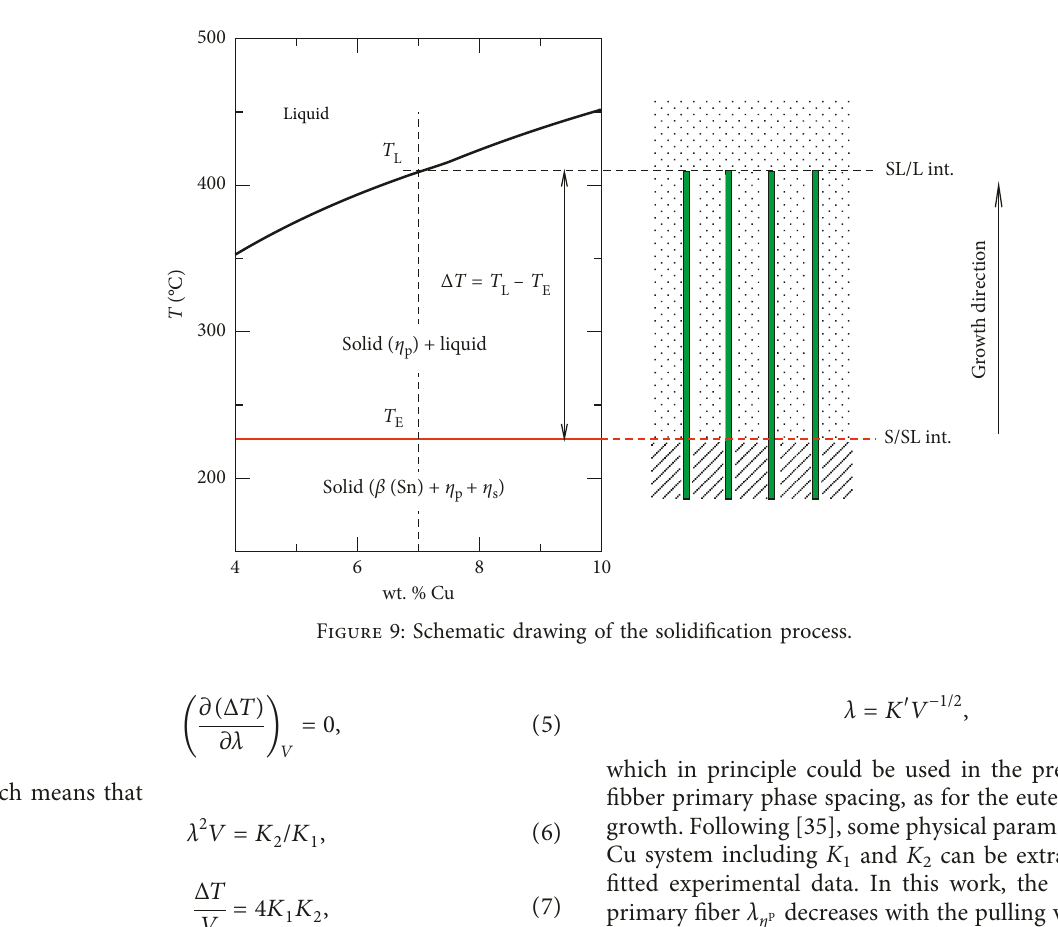
and λ as a function of pulling velocity. η P η S